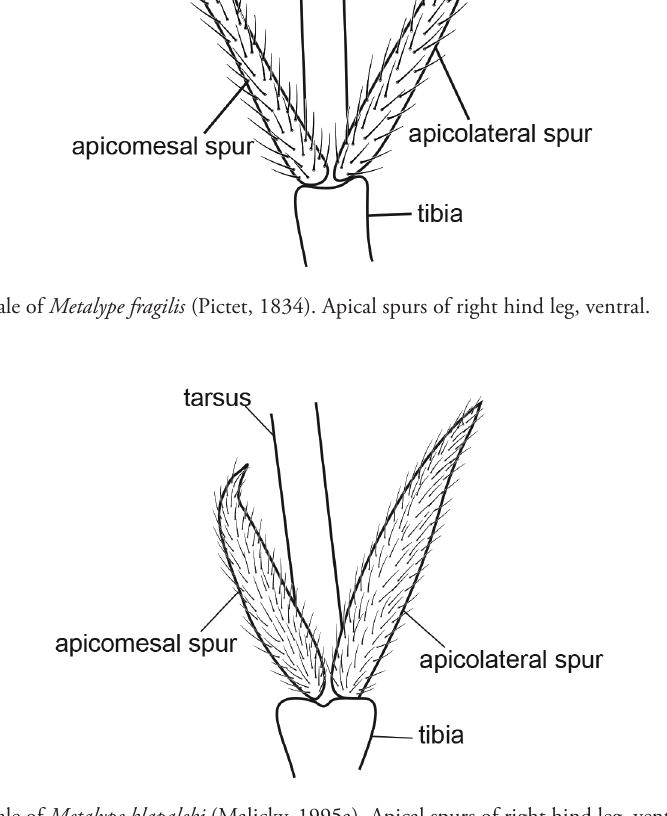
Figure 7. Male of Metalype klapaleki (Malicky, 1995a). Apical spurs of right hind leg, ventral.